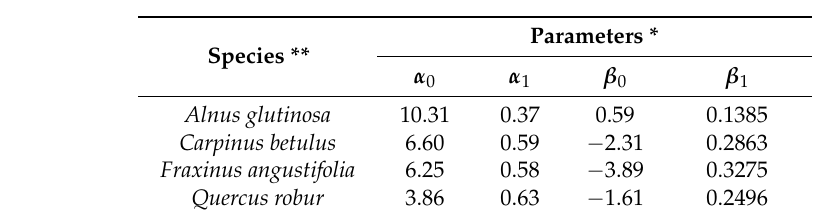
Table A2. Parameters for species-specific, age-dependent tree height curves ( h = ( α 0 + α 1 × Age ) × − ( β 0 + β 1 · Age ) e DBH + 1.30).